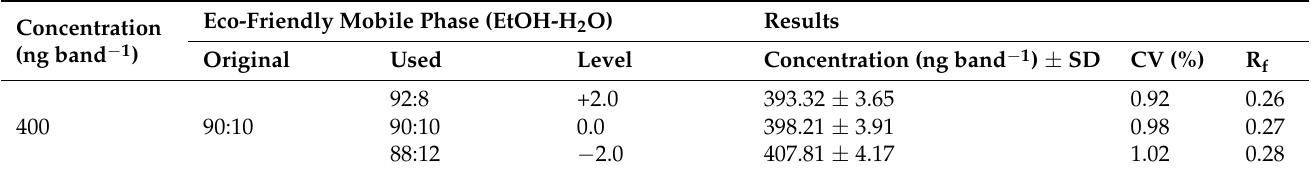
Table 5. Findings of CIN robustness for the present approach (mean ± SD; n =